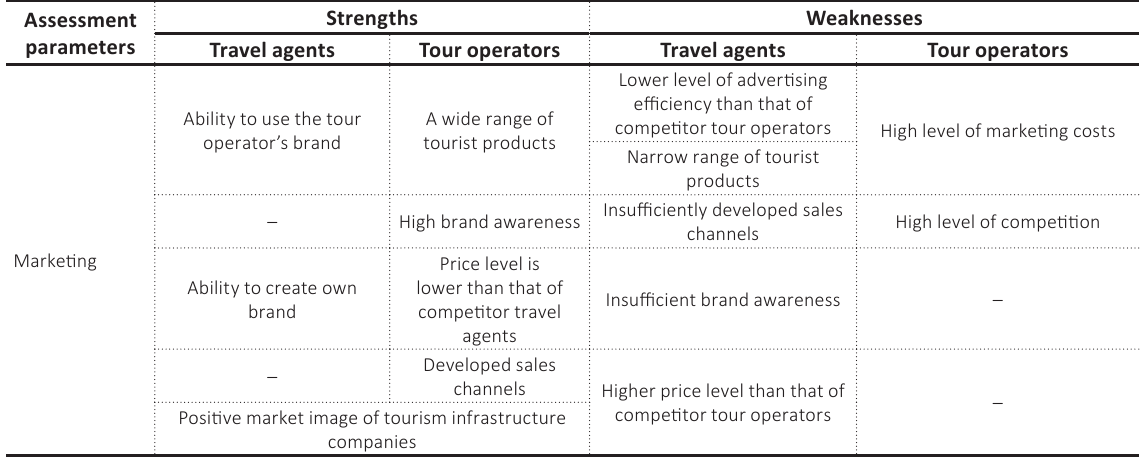
Table 6 (cont.). Strengths and weaknesses of major tourism infrastructure companies